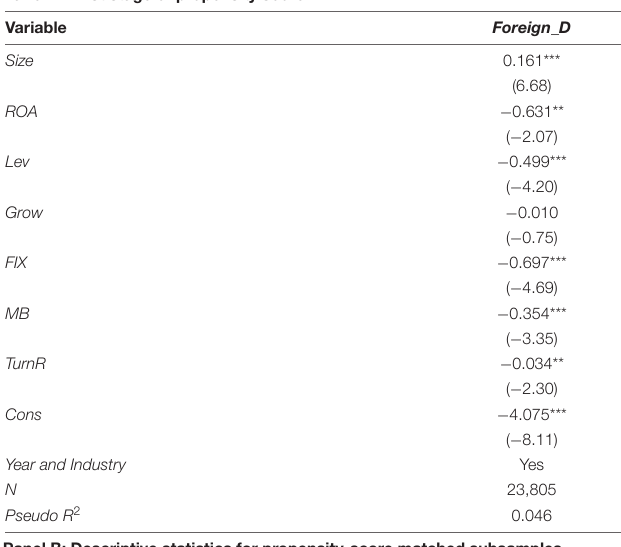
TABLE 7 | PSM procedure. Panel A: First stage of propensity